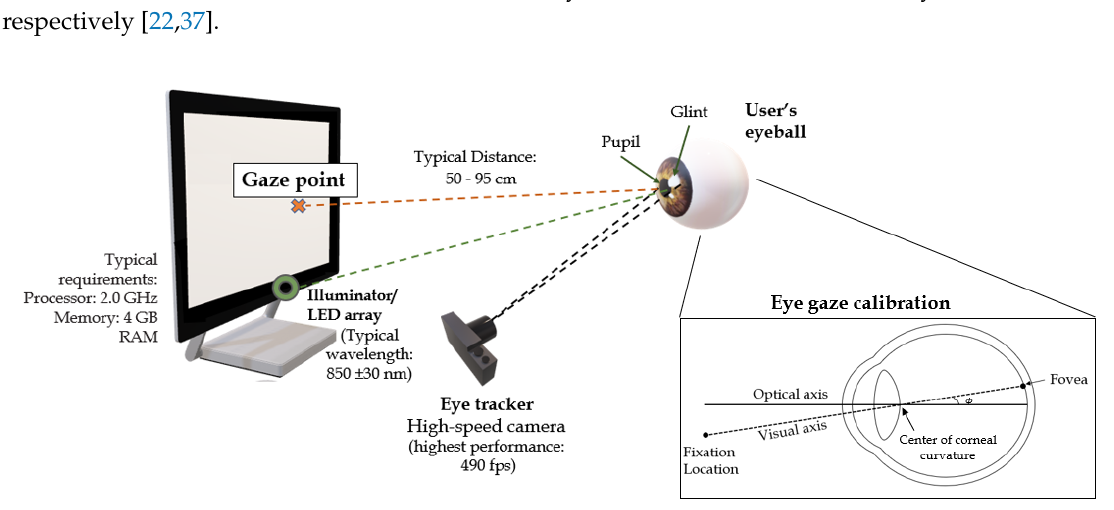
Figure 2. Components of a typical eye gaze system, adapted from [22,38]. The optical and the visual axes are used for the calibration process commonly required to set up the eye gaze system